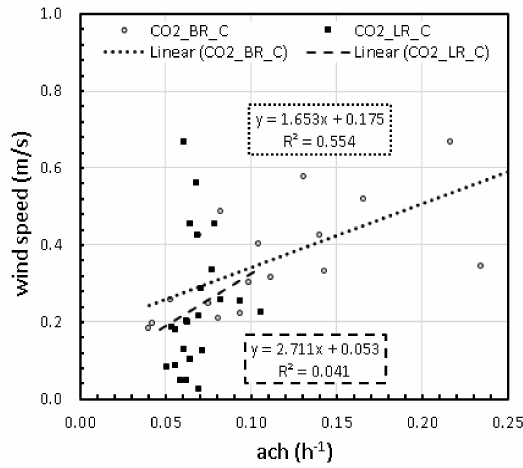
Figure 10. Air change rate versus wind speed: Carbon dioxide (CO 2 )—door closed.